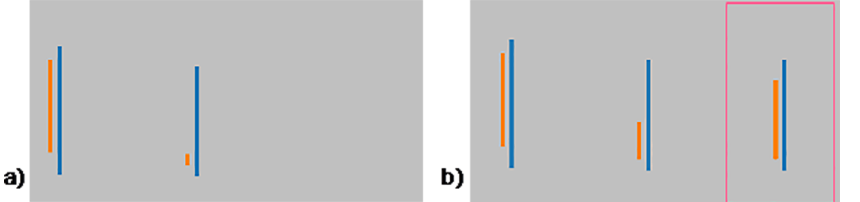
Figure 12. Sequential screenshots from a dynamic perceptual ratio matching task. (a) Participants are initially presented with a target ratio composed of line segments on the left side of the screen along with an incomplete ratio to the right. Participants are asked to adjust the components of the incomplete ratio so that the two match. In this case participants are asked to adjust the length of the orange bar to try to make the orange:blue line ratios match. (b) Once the participant submits a response, the computer gives feedback on what the correct answer would have been (farthest right). In this case, the red box lets the participant know that their submission (center) is quite far from the correct value. Note that for these ratios, the jitter between orange and blue lines is an irrelevant dimension that ensures participants cannot make a match by simple scaling of an identical